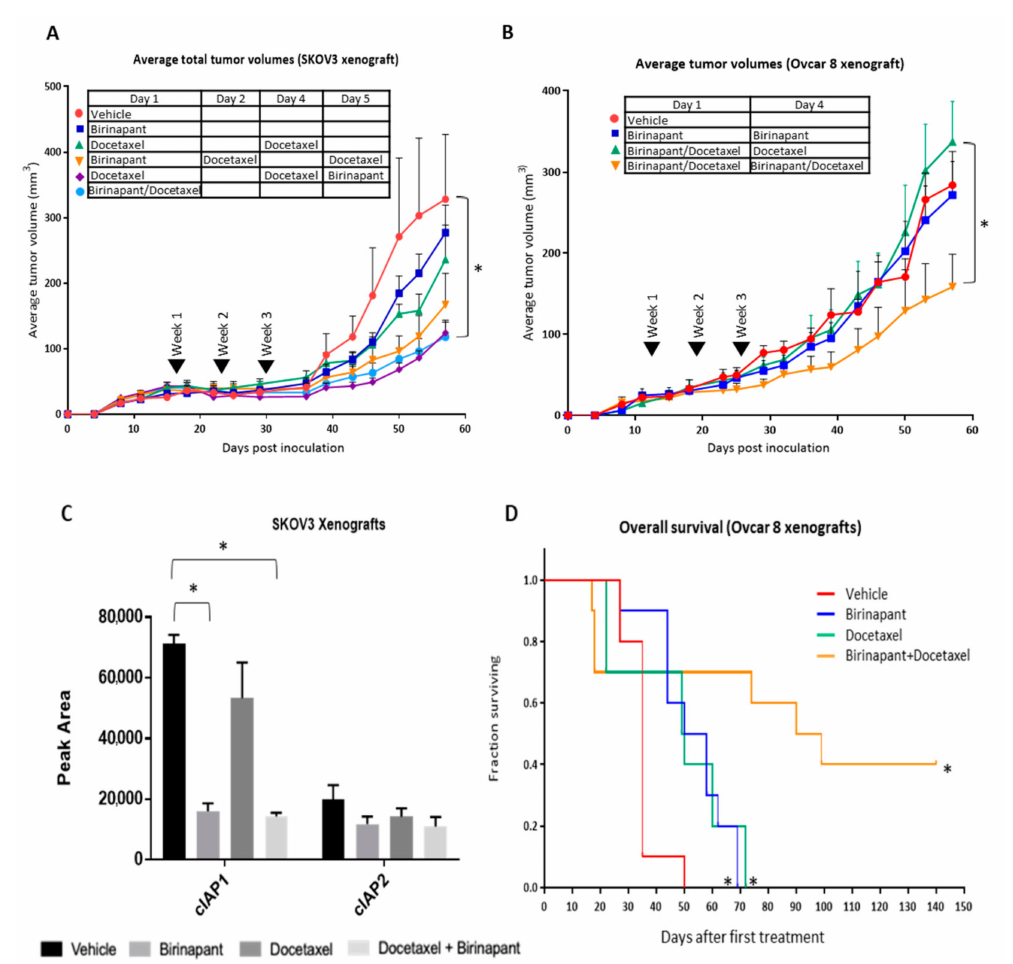
Figure 6. Docetaxel is synergistic with birinapant in vivo. ( A ) Athymic nude mice were inoculated subcutaneously with SKOV3 ovarian cancer cells. Mice were randomized into treatment groups after tumors achieved an average volume of 50–100 mm 3 . Average total tumor volumes over time were measured by calipers following 3 weeks of vehicle, single-agent, or combined intraperitoneal (IP) treatments of birinapant 15 and docetaxel 6 mg / kg. Treatments occurred simultaneously or sequentially, as shown in the inset table. SKOV3 xenografts were established subcutaneously. ( B ) In another subcutaneous model using OVCAR8 cells, the e ff ect of dosing mice once weekly was compared to split dosing twice weekly, as indicated in the inset table. Measurements were carried out as in ( A ). ( C ) In a separate experiment, subcutaneous SKOV3 xenografts were harvested after one week of treatment. Protein was extracted and capillary western blot was used to quantify cIAP1 and cIAP2. * p < 0.0001. ( D ) OVCAR8 cells were inoculated intraperitoneal into athymic nude mice. Survival was monitored after receiving 3 weekly IP treatments of single or combined birinapant 15 and docetaxel 6 mg / kg. Log-rank test was performed to determine statistically significant di ff erences in survival. * p < 0.001. Error bars in all panels indicate standard error of the